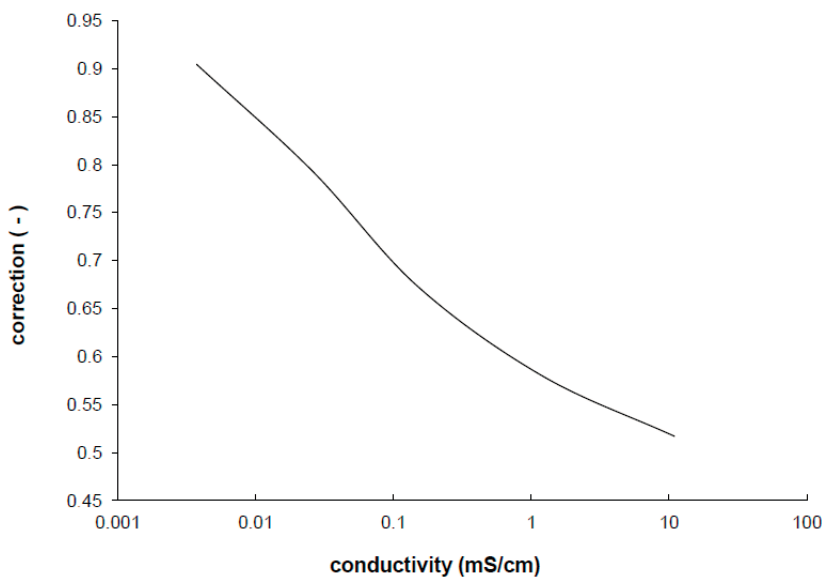
Figure 4. The correction factor of the cell constant experimentally determined from the measurement of the screen printed